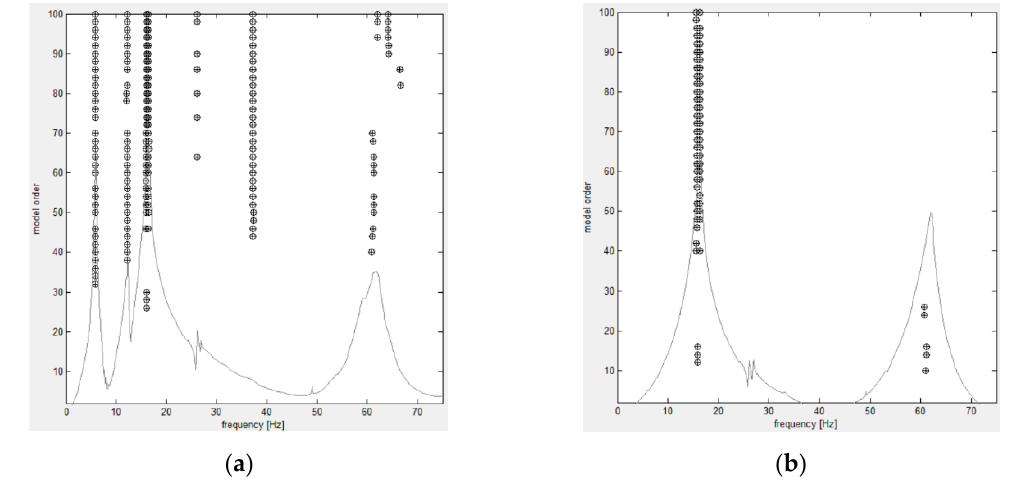
Figure 8. The stabilization diagram for the 4th level of the prestress, 4x direction of acceleration signal and the impulse at node P4 in direction: ( a ) 120 degrees and ( b ) 330 degrees.